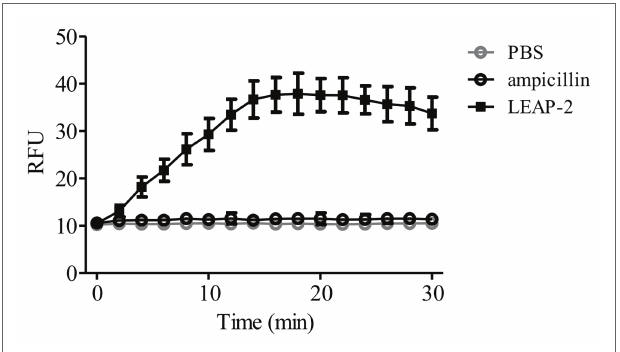
FIGURE 5 | Effects of topmouth culter LEAP-2 on membrane permeabilization of A. hydrophila . A. hydrophila (10 6 CFU/ml) suspended in PBS were incubated with topmouth culter LEAP-2 (1 × MIC), ampicillin (1 mg/ ml) or PBS (vehicle) in the presence of SYTOX (0.1 μ M) at 37 ° C for 15 min on a shaking table. Fluorescence intensity was monitored and presented as relative fluorescence unit (RFU).